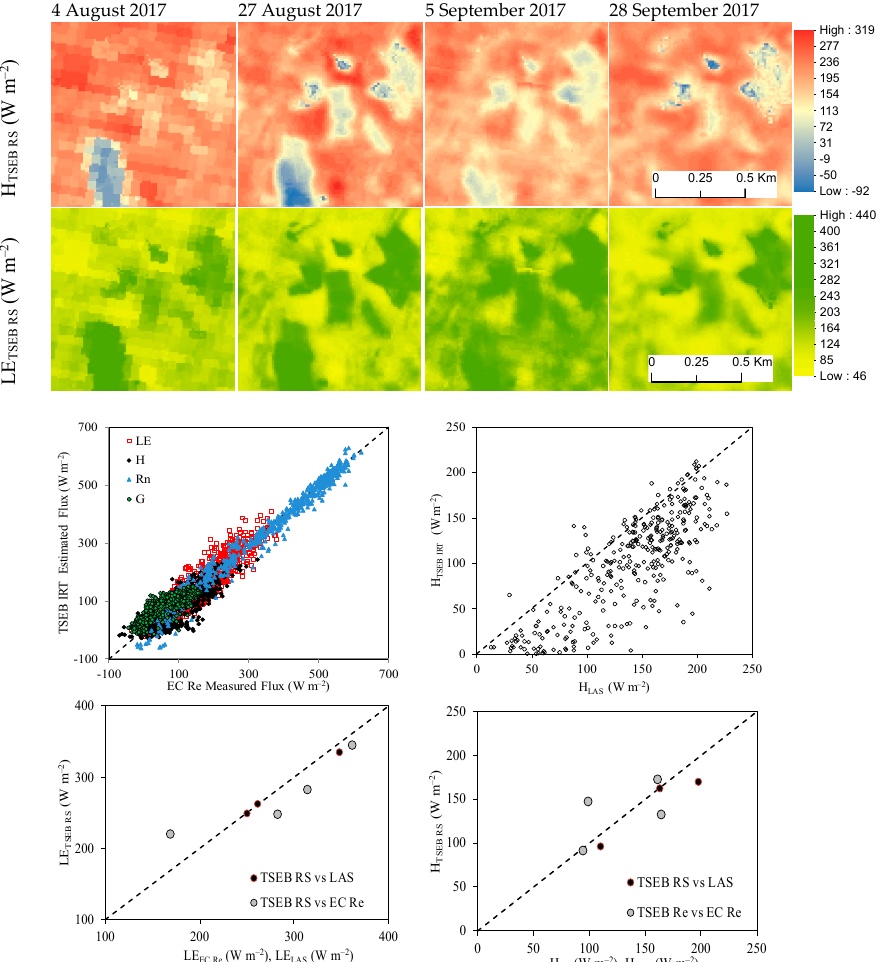
Figure 9. Maps of the two-source energy balance (TSEB) model estimates of H TSEB ( top row ) and LE TSEB ( second row ) based on Landsat, comparison between EC Re measurements and TSEB IRT estimates of Rn, G, H, and LE ( third row left ), scatter plot of H LAS and H TSEB IRT ( third row right ), comparison of footprint integrated LE TSEB RS , LE EC Re , and LE LAS ( bottom left ), comparison of H TSEB RS , H EC , and H LAS ( bottom right